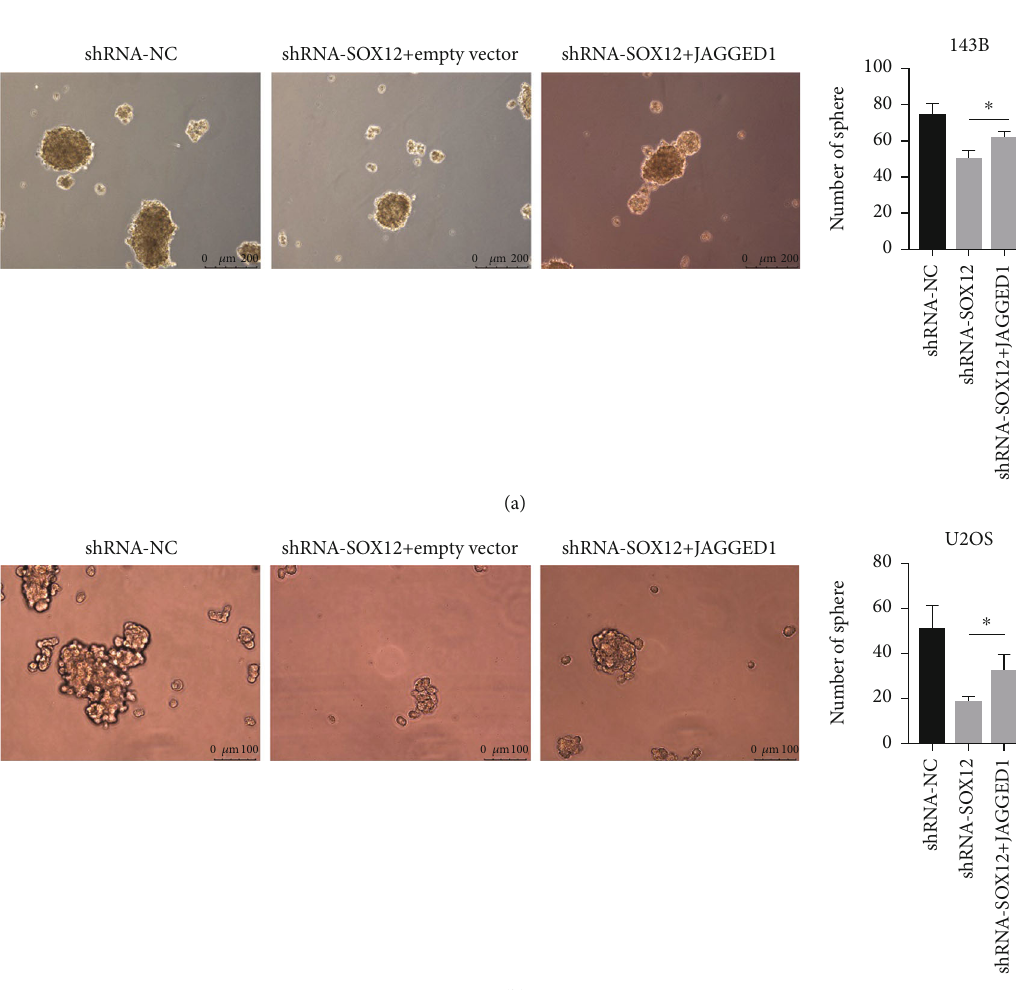
Figure 8: JAGGED1 overexpression partially rescues the spheroidizing ability of osteosarcoma cells. (a) JAGGED1 overexpression partially rescues the spheroidizing ability of 143B osteosarcoma cells. (b) JAGGED1 overexpression partially rescues the spheroidizing ability of U2OS osteosarcoma cells. ∗ p < 0 : 05